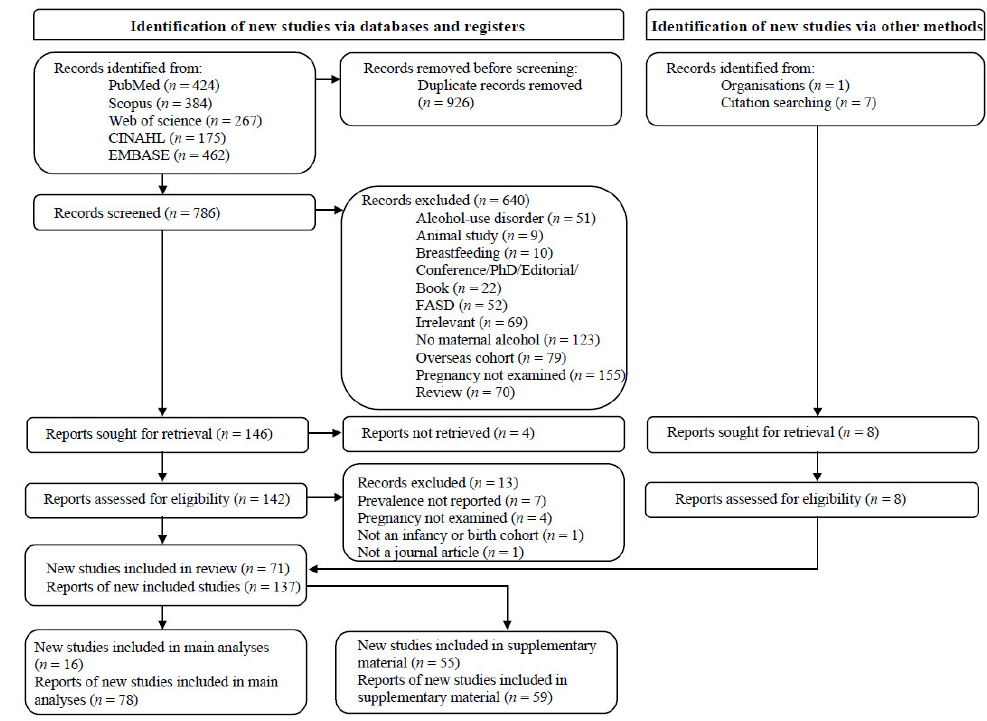
Figure 1. PRISMA flow diagram.